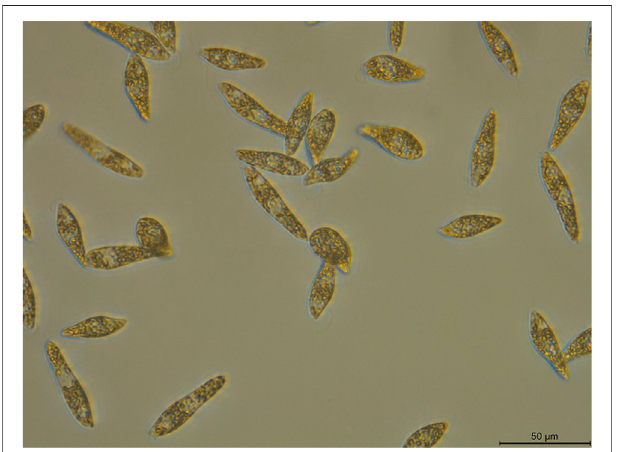
FIGURE 1 | Morphology of E. gracilis 815. Scale bar: 50 μ m.